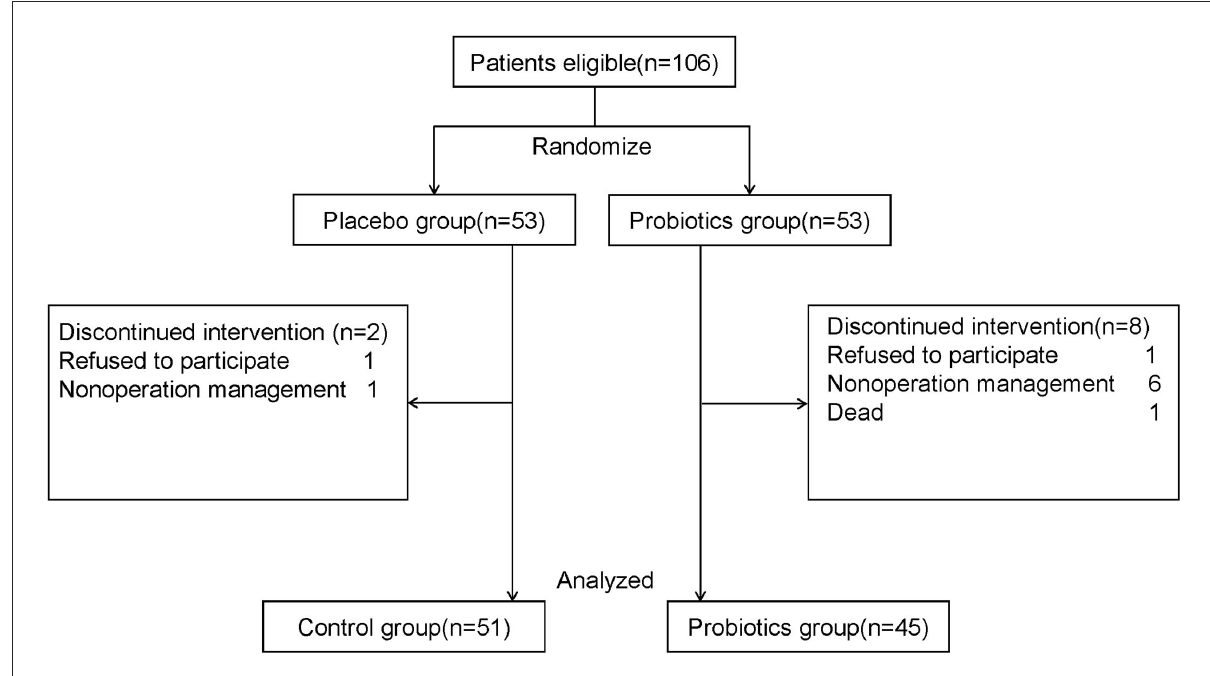
FIGURE1 Flow chart of study: Participant eligibility and enrollment are